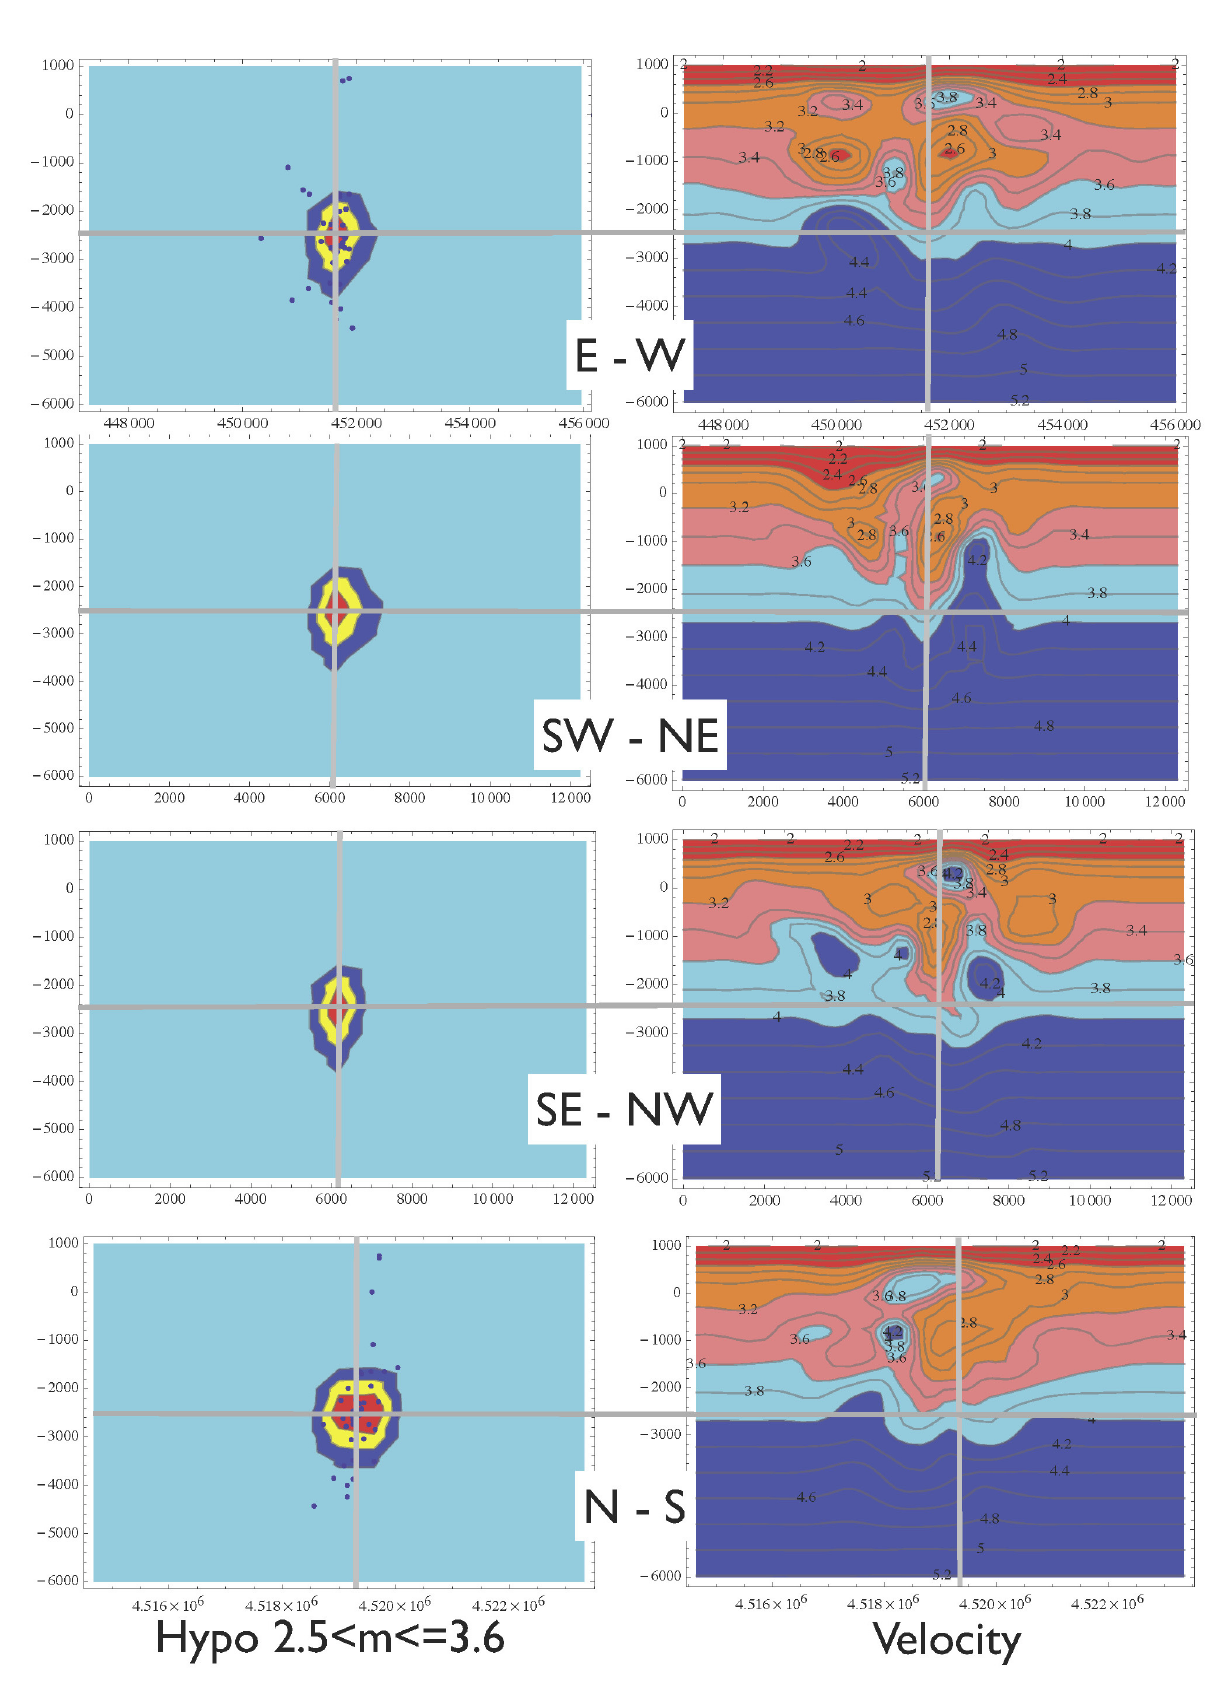
Figure 5. Left panels shows the location probability in the sections EW, NS, SW-NE and SE-NW respectively. The probability is calculated along the sections, and is not integrated along the third coordinate axis. Points in sections N-S and E-W represent all the hypocenter of earth- quakes with magnitudes greater than 2.5, projected onto the section